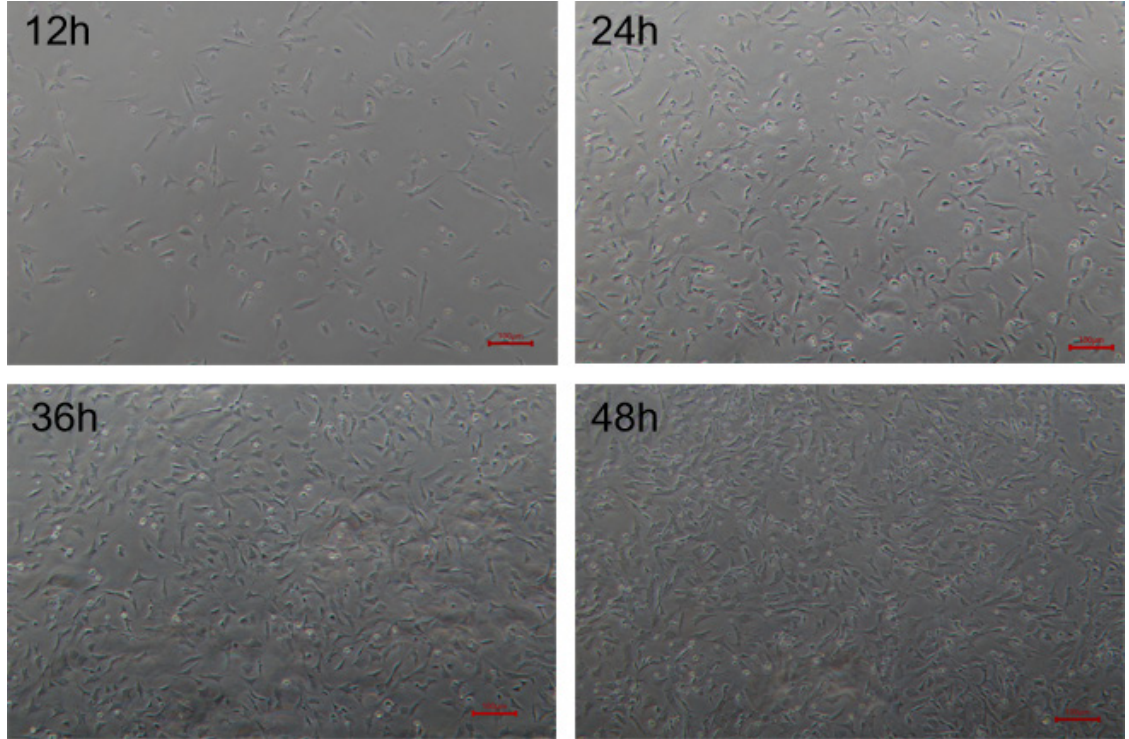
Figure 1. Morphological observation of isolated goose skeletal muscle satellite cells at different time. Cells were observed at 12, 24, 36, and 48 h after culture under microscope with white light